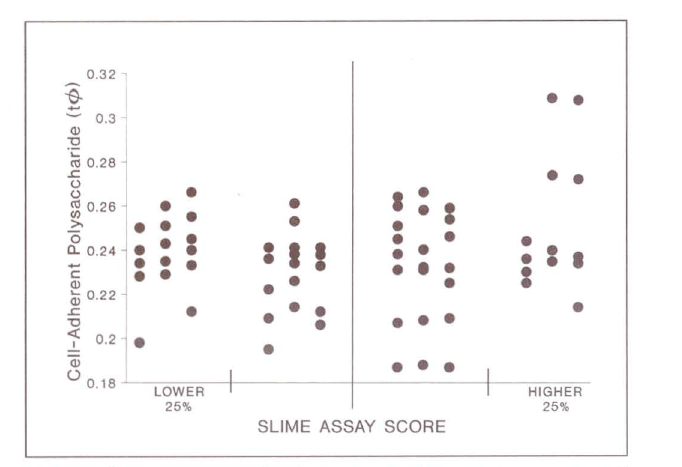
Figure 1) Cell-associatedpotysaccharide (tryptophan assay. t0) for one patient population, n=68. Points represent mean